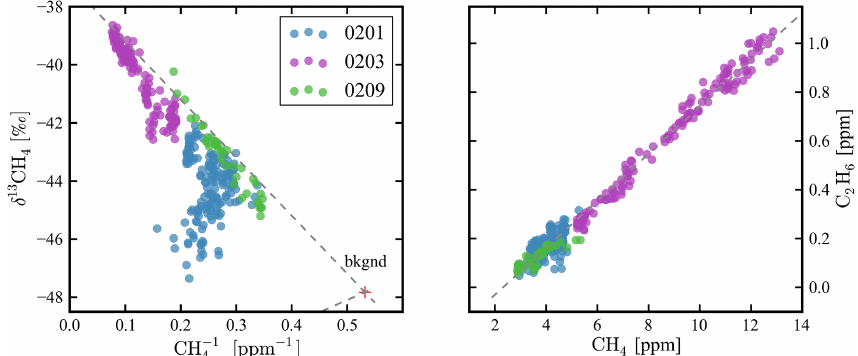
Figure 16. Left panel: Keeling plot of δ 13 CH 4 vs. (CH 4 ) − 1 for the three drives on 1 February (0201), 3 February (0203), and 9 February (0209) in 2013. The point labeled “bkgnd” is the measurement of Niwot Ridge, Colorado, air by NOAA in February 2012: CH 4 = 1 . 877ppm (Dlugokencky et al., 2015) and δ 13 CH 4 = − 47 . 412‰ (White and Vaughn, 2014). The top gray line indicates a source of gas with a − 37 . 2‰ isotope ratio (the centroid of the individual gas sources in Fig. 12), and the bottom gray line indicates a source of − 52 . 3‰ (the centroid of the individual oil sources in Fig. 12). Clearly the majority of the observed isotope ratios are dominated by gas sources. Right panel: plot of ethane vs. methane for the same three drives. The gray dashed line follows an ethane-to-methane ratio of 0.096.